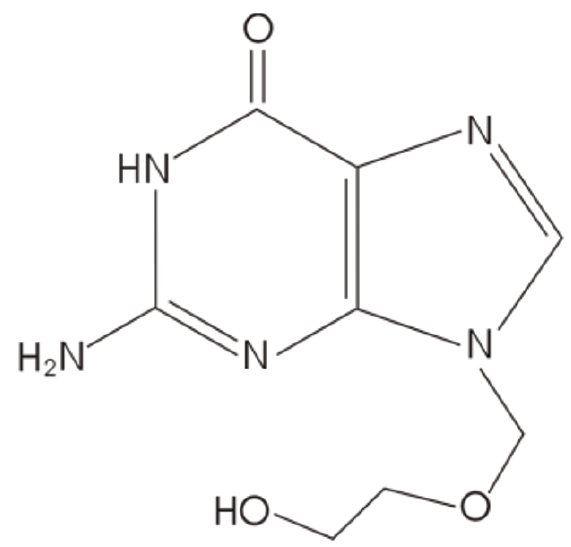
Figure 1. Chemical structure of